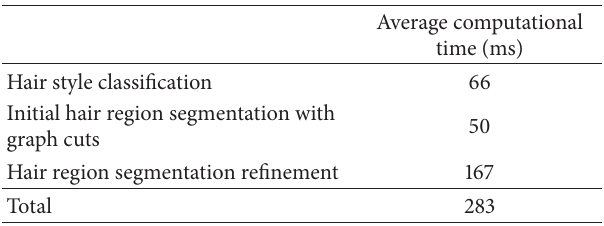
Table 6: Computational cost